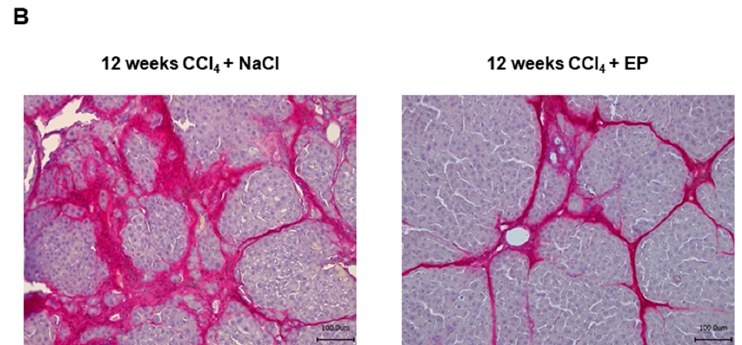
Figure 2. Glyoxalase-I in CCl 4 -induced cirrhosis. ( A ) Wistar rats were treated for 12 weeks, three times per week, with inhalative CCl 4 to induce advanced cirrhosis. Explanted livers were fixed in 4% formaline, dehydrated, and embedded. Immunostaining for Glo-I with DAB compound was performed as previously described [83]. Overview sections (5× magnification, upper line) and sections at 20× magnification (lower line) showed reduced expression of Glo-I in advanced cirrhosis; ( B ) Wistar rats were treated with CCl 4 and intraperitoneally (i.p.) EP 40 mg/kg body weight daily or saline from weeks 8–12. Explanted livers were fixed, dehydrated, and embedded. Sirius red staining was performed as previously described [83]. Sections showed reduced amount of Sirius red upon EP treatment. Scale bars: 400 µm ( A , upper line), 100 µm ( A , lower line, B ).